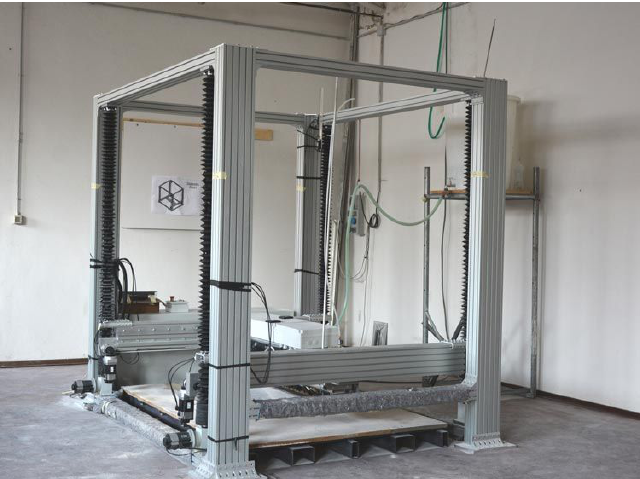
Figure 2. The 3D-Printer employed in the ADMIN 4D